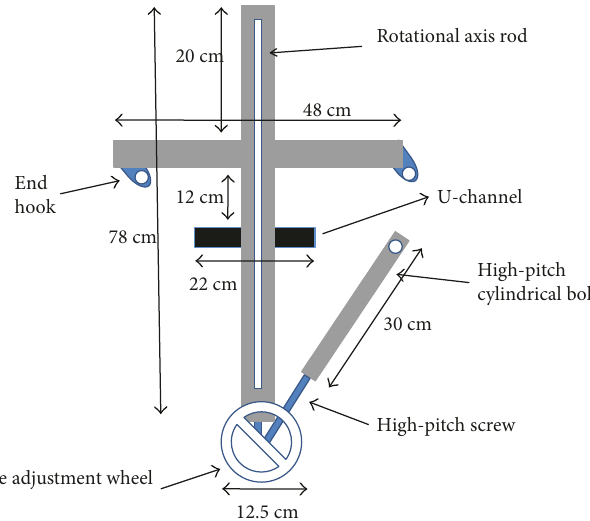
Figure 4: Schematic diagram of the frame allowing the orientation control of the parabolic re fl ectors along the